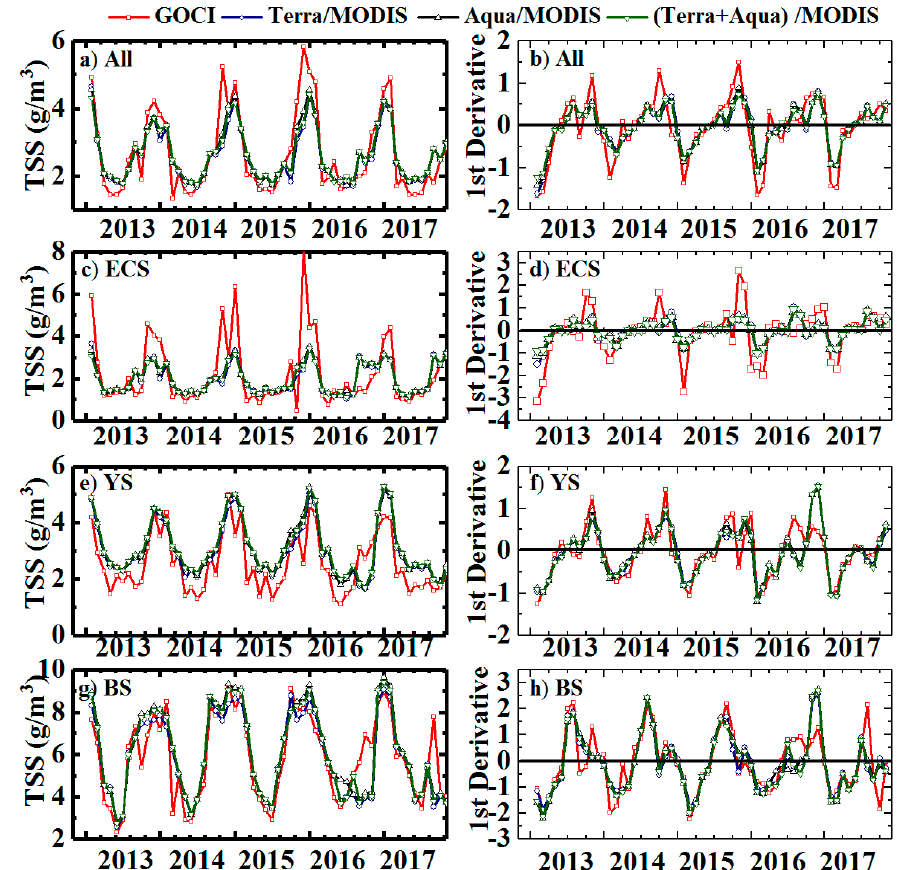
Figure 15. Monthly statistics and first derivative of TSS variations observed from GOCI, “simulated” Terra / MODIS, Aqua / MODIS and Terra + Aqua observations. Table 4. Monthly statistics of TSS (g / m 3 ) variations from GOCI, “simulated” Terra, Aqua and Terra + Aqua